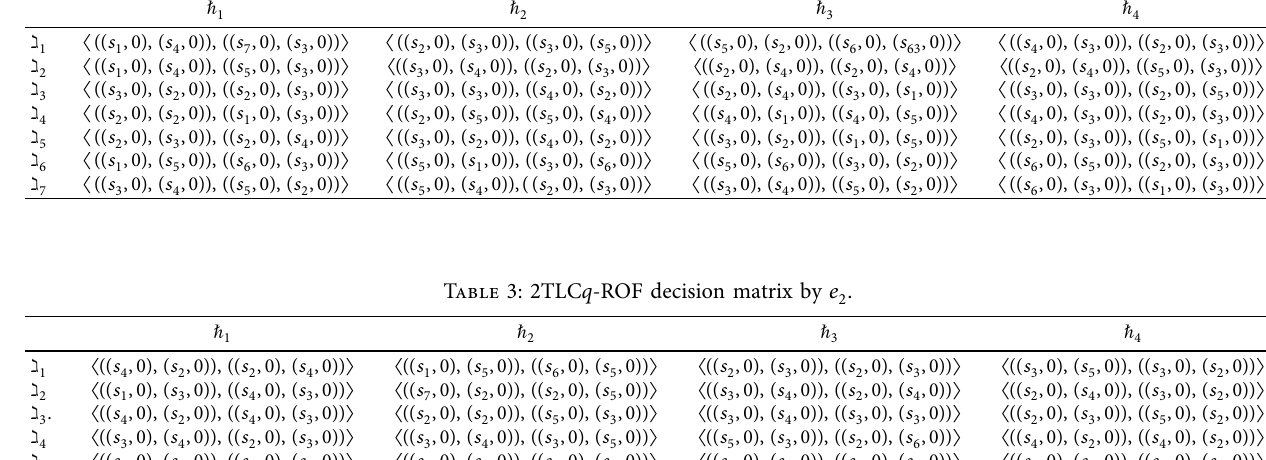
Table 2: 2TLC q -ROF decision matrix by e